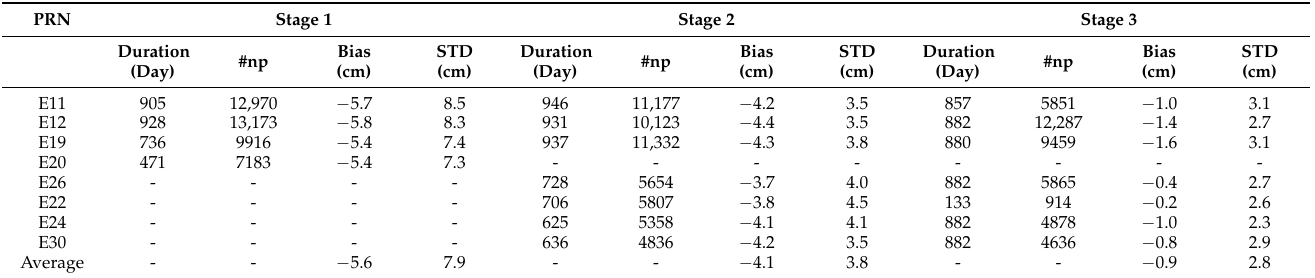
Table 5. Statistical information for SLR residuals calculated from COM orbits. Duration refers to the accumulated effective time for orbit products, in which the period of interruption is subtracted. Only the number of SLR normal points over the accumulated effective time were included in orbit validation